Question: Briefly state, in one sentence, what is plotted here.
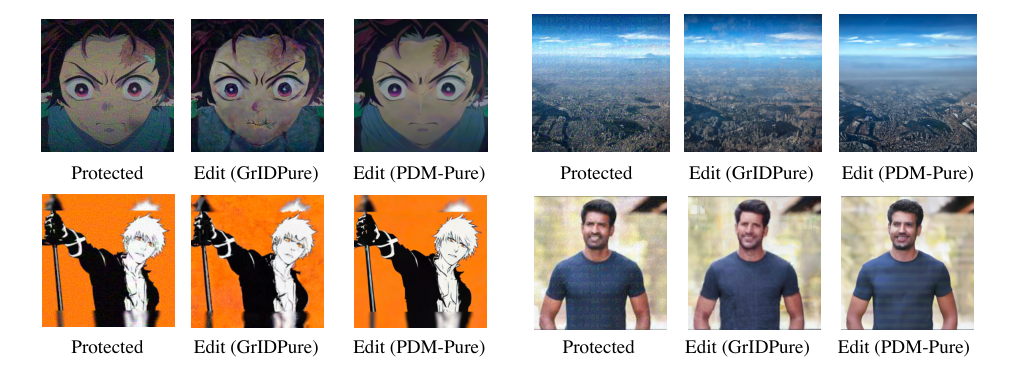
Answer: PDM-Pure vs GrIDPure: PDM-Pure is better than GrIDPure, especially when the adversarial pattern is strong such as AdvDM. The bottom half of this figure shows the editing results of purified images, we can see that the editing results of GrIDPure still show somewhat artifacts.